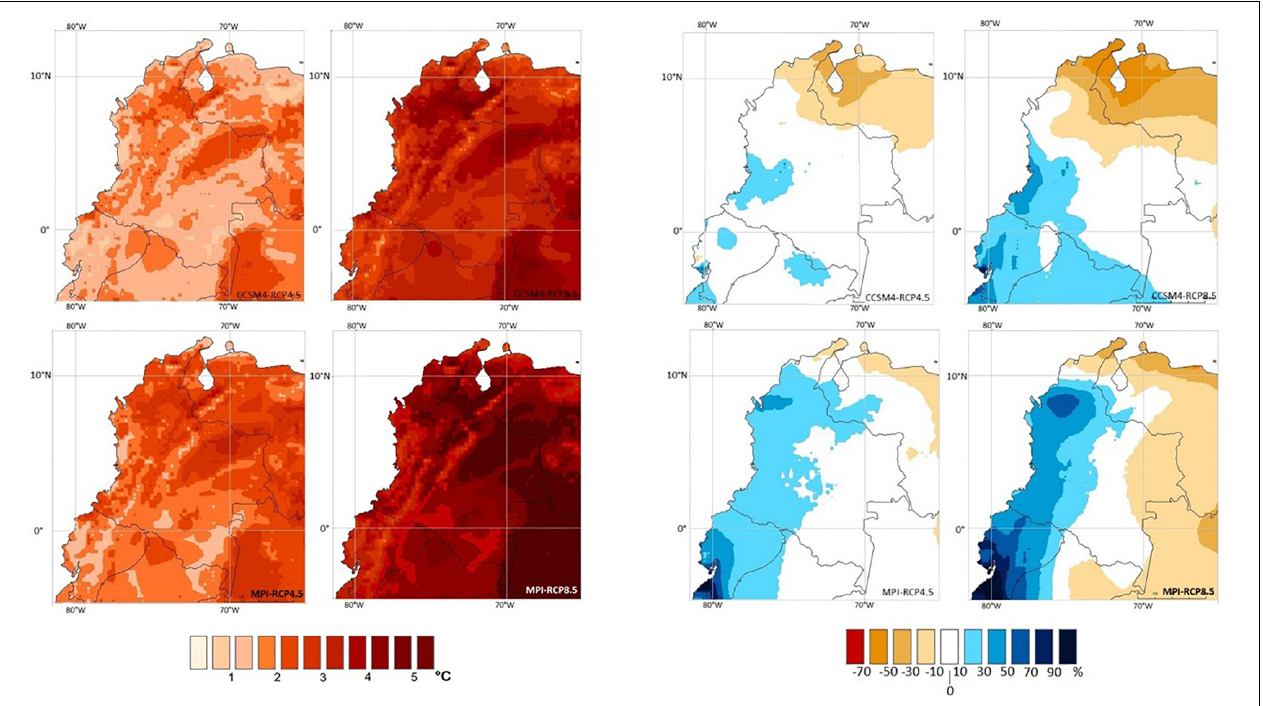
FIGURE 11 | Projected changes in annual temperature (left; in ◦ C) and annual precipitation (right; in% related to annual average 1976–2005 period) over the north tropical Andes as obtained with dynamical downscaling of CCSM4 (top) and MPI (bottom) under RCP4.5 and RCP8.5 scenarios. Weather Research Forecast (WRF) model was used to downscale to spatial resolution 10 × 10 km. After Armenta-Porras and Pabón-Caicedo (2018).